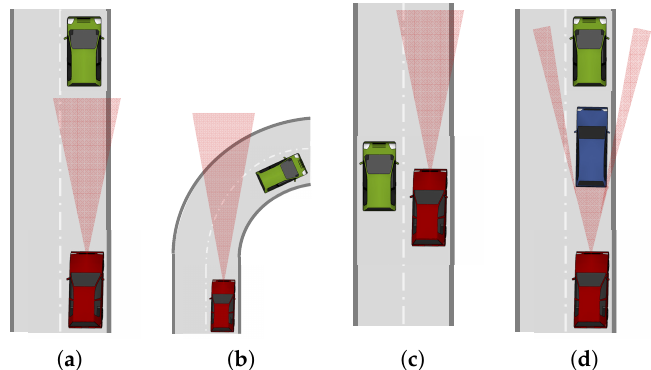
Figure 3. The four figures depict situations where a ranging sensor at the red ego vehicle has a limited performance in estimating the relative position of the green target vehicle. Either because of a limited sensing area in terms of range ( a ), or aperture ( b , c ), or due to an obstacle that blocks the line-of-sight ( d